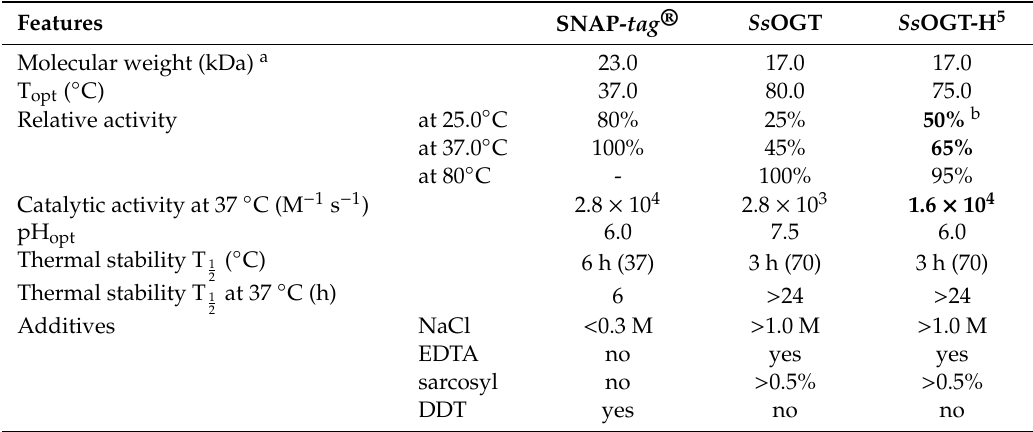
Table 3. Biochemical properties comparison among SNAP- tag , Ss OGT and the relative H 5 mutant.